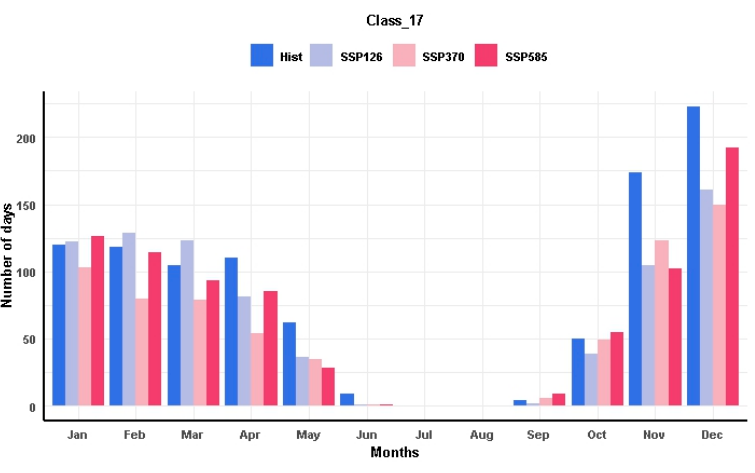
weaken in future patterns (Figure 20).